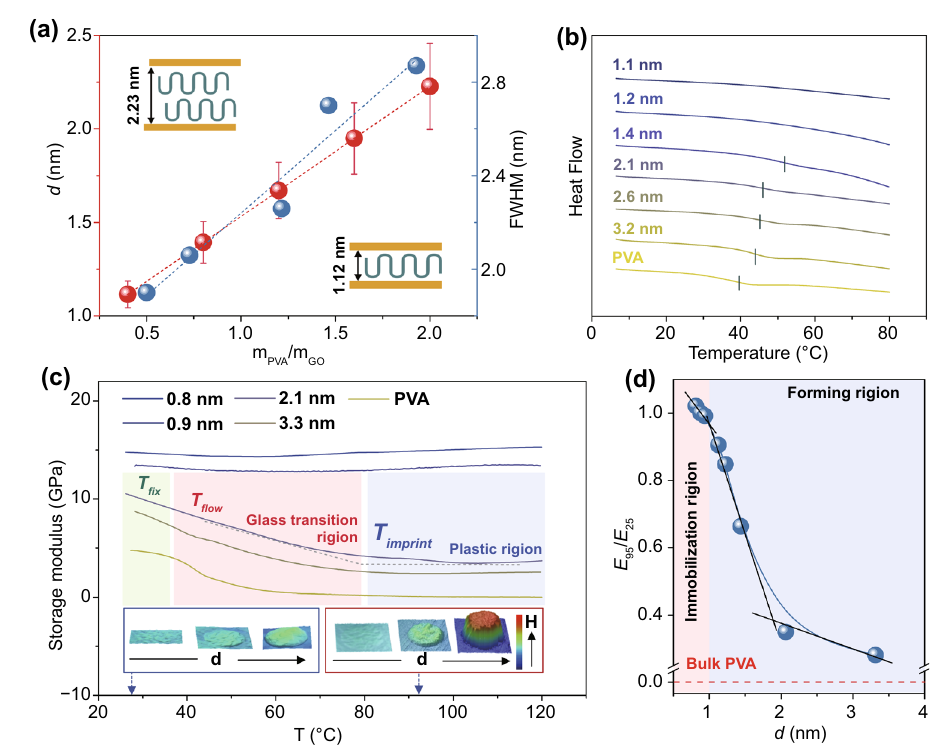
Fig. 2 a Plots of the interlayer spacing and FWHM versus the weight ratio between PVA and GO. The insets presents the comparison between 1.12 nm ( m PVA / m GO = 0.4) and 2.23 nm ( m PVA / m GO = 2). b Glass-transition temperature measurement of Pi-GOS with different interlayer spac- ing. c Curves of storage modulus versus temperature with increasing interlayer spacing. The insets are the deformation abilities of forming structure versus d at 25 °C (blue) and 95 °C (red). d A plot of the ratio between storage modulus at 95 °C (E 95 ) and that at 25 °C (E 25 )